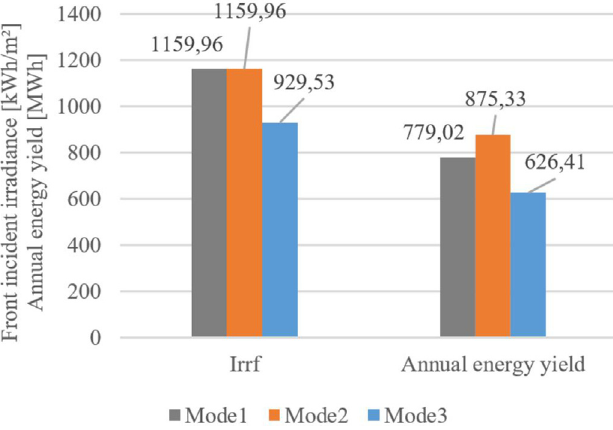
Fig. 5. The fi gure illustrates front irradiance and annual energy yield for simulations on plant Germany. Comparisons to the measured front irradiance and energy yield can be made, but exact values cannot be disclosed in this article. The simulated values of modes 1 and 2 are identical due to being calculated using VF and both are close to the measured front irradiance. mode 3 with RT based calculations shows a larger deviation. For the energy yield, mode 1 is closest to the measured data, whereas mode 3 shows a signi fi cant negative deviation to the real